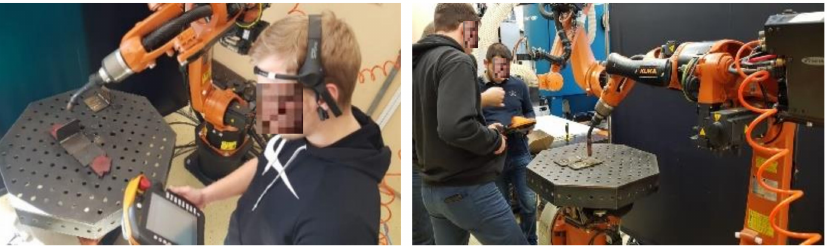
Figure 5. Lab learning robot welding